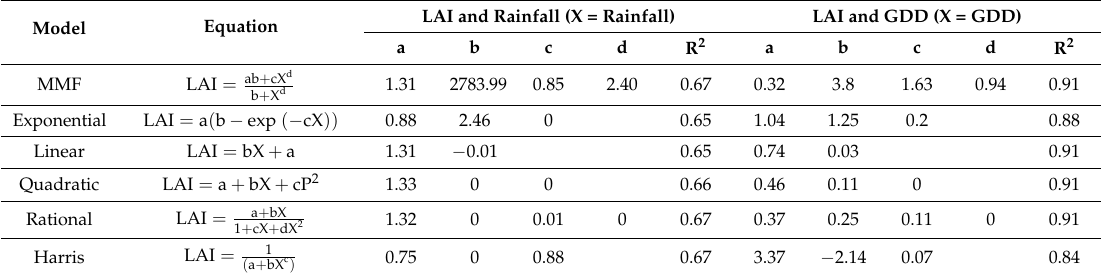
Table 3. The tested relationships between LAI, rainfall (P) and GDD, a, b, c and d are parameters. Model